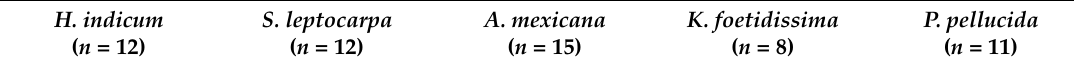
Table 5. Shared social conditions of the study species and the Rahman Similarity Index